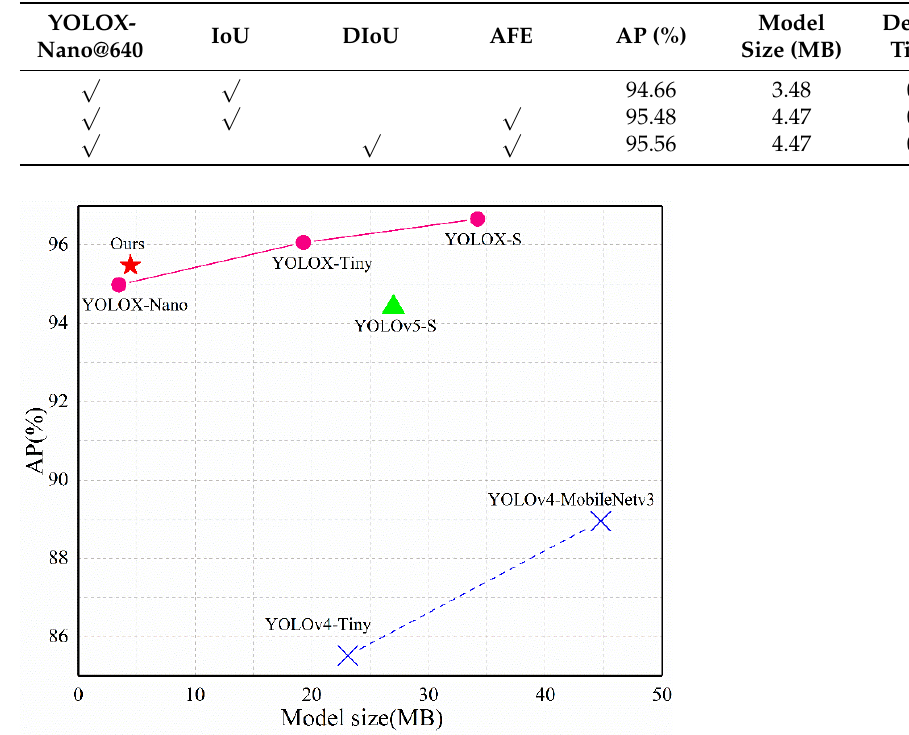
Table 4. The impact of each module on model performance.